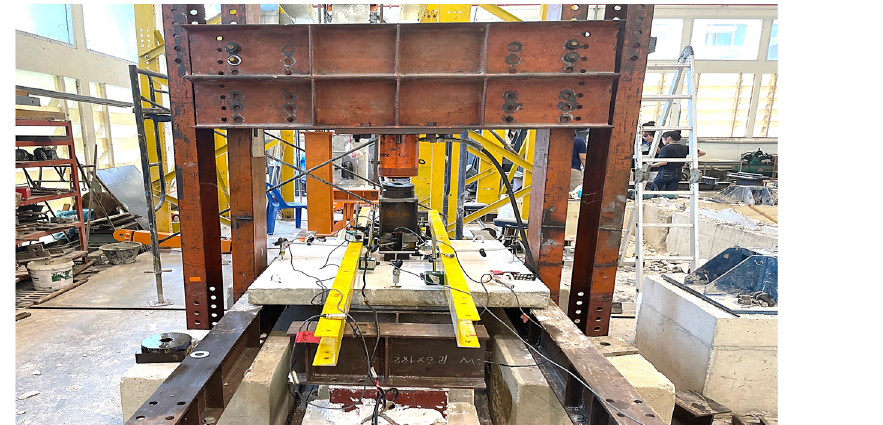
Figure 6. Actual test configuration.